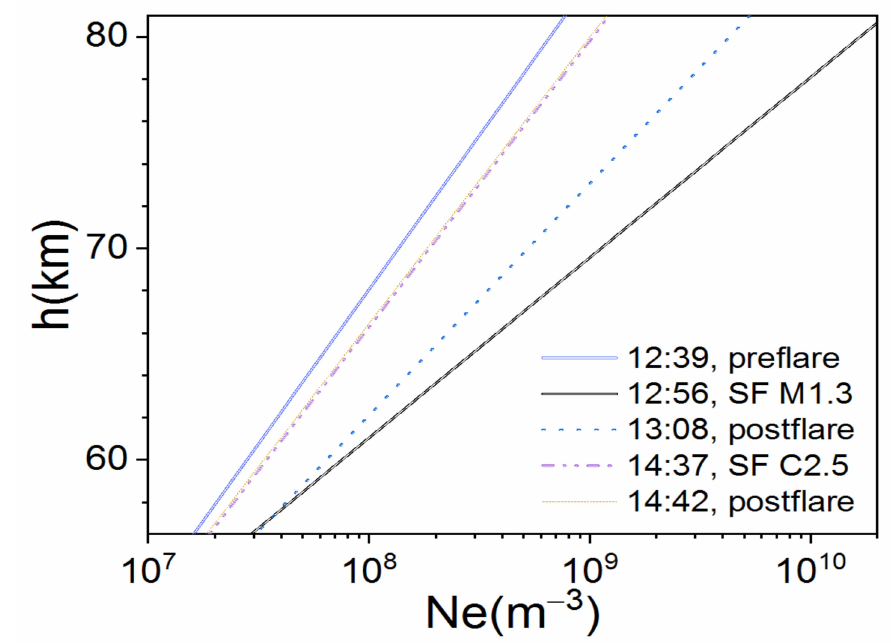
Figure 4. The altitude profile of electron density during two successive SFs on 10 May